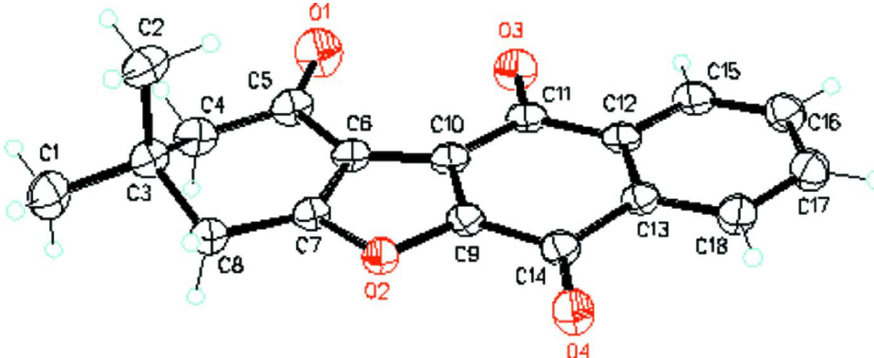
Figure 1 The molecular structure of the title compound with 30% displacement ellipsoids.